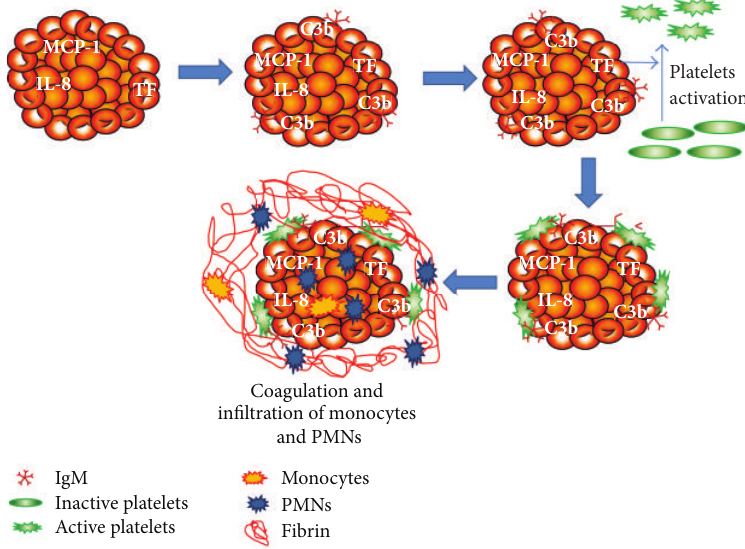
Figure 2: Mechanisms of the instant blood-mediated inflammatory reaction. PMNs: polymorphonuclear cells.